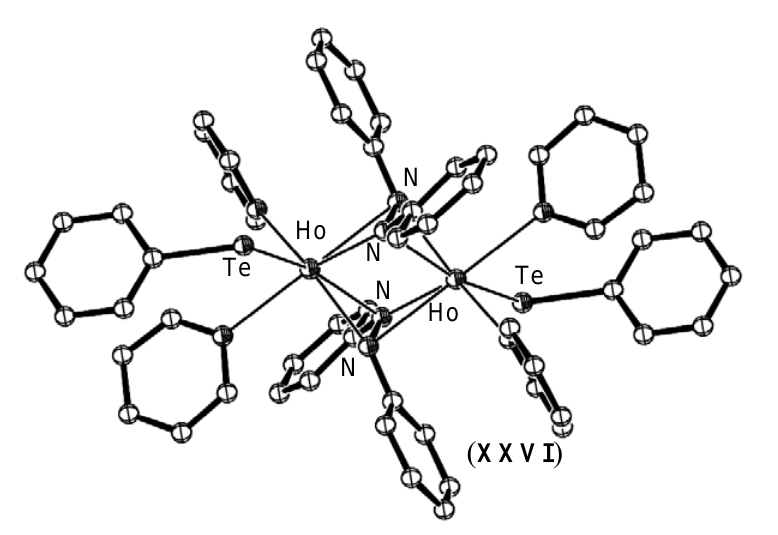
Figure 13. Molecular structure of [{Ho(PhNNPh)(TePh)(C generated from CCDC obtained coordinates. Atoms of arbitrary size. H atoms, two pyridine molecules of crystallisation and one of the two independent molecules in the asymmetric unit are omitted for